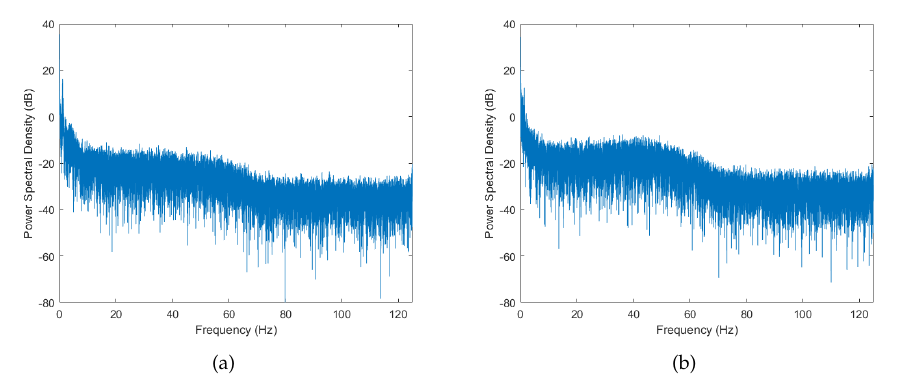
Figure 7. The PSD of cycling activity. ( a ) Scenario 1; ( b ) Scenario